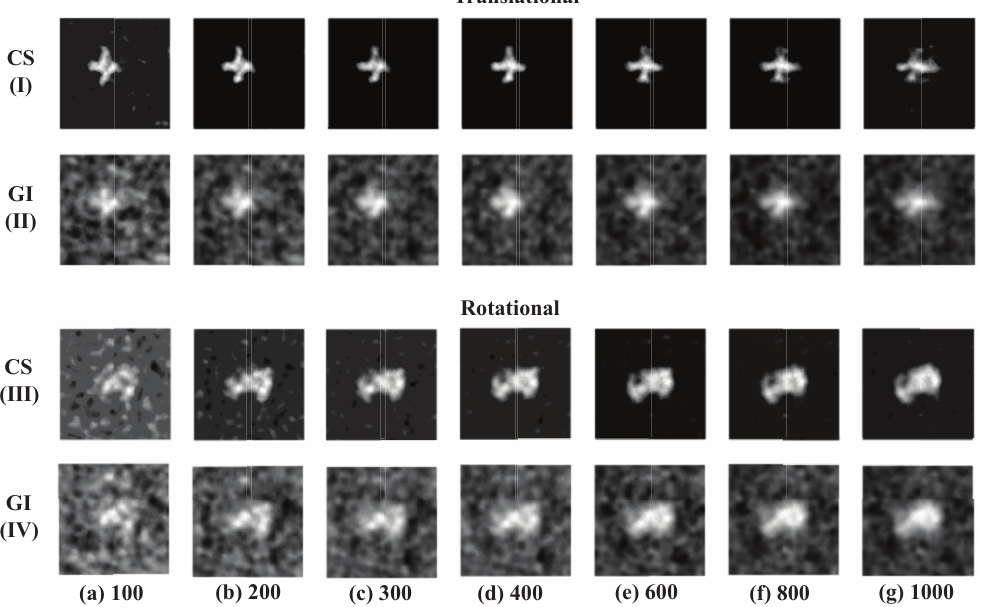
Figure 7. The image performance of the moving object with a constant speed against ( a ) 100 to ( g ) 1000 number of measurements under different conditions: translational moving object using ( I ) CS, ( II ) GI, rotational moving object using ( III ) CS, ( IV )